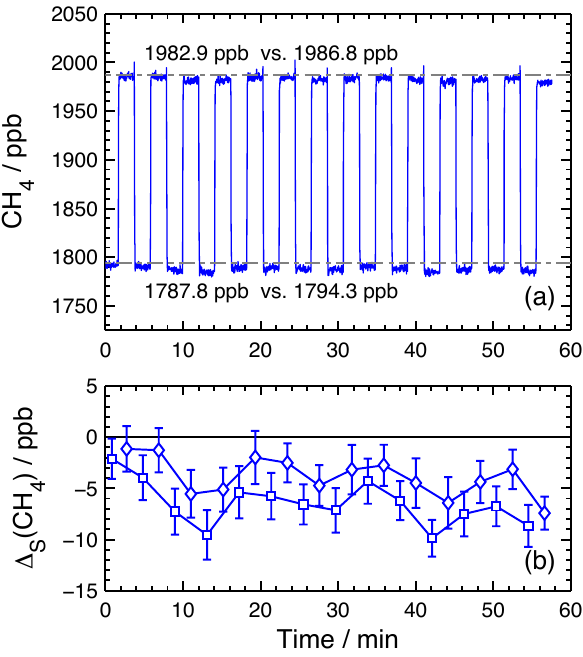
Fig. 4. (a) Sequential measurement of two known calibration gas mixtures (1986.8ppb, 1794.3ppb) yielded an accuracy within the 60min measurement time of 6.5ppb ( < 0 . 5%). Horizontal lines indicate the mixing ratio of the respective gas standard as determined by gas chromatography. (b) Difference of average FGGA measurements to gas standard mixing ratio ( (cid:5) 1986.8 ppb; (cid:3) 1794.3 ppb). The accuracy is mostly determined by instrumental drift.